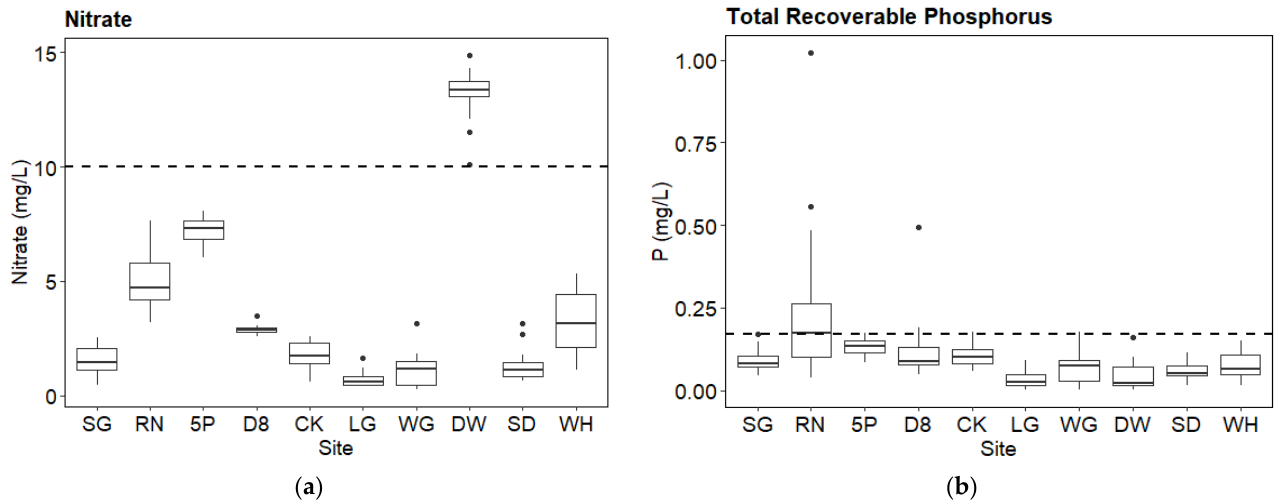
Figure 2. Nutrients that exceeded CDPHE standards were nitrate and total P: ( a ) Boxplot results with the acute CDPHE standard for nitrate. ( b ) Boxplot results with the CDPHE standard for total P.